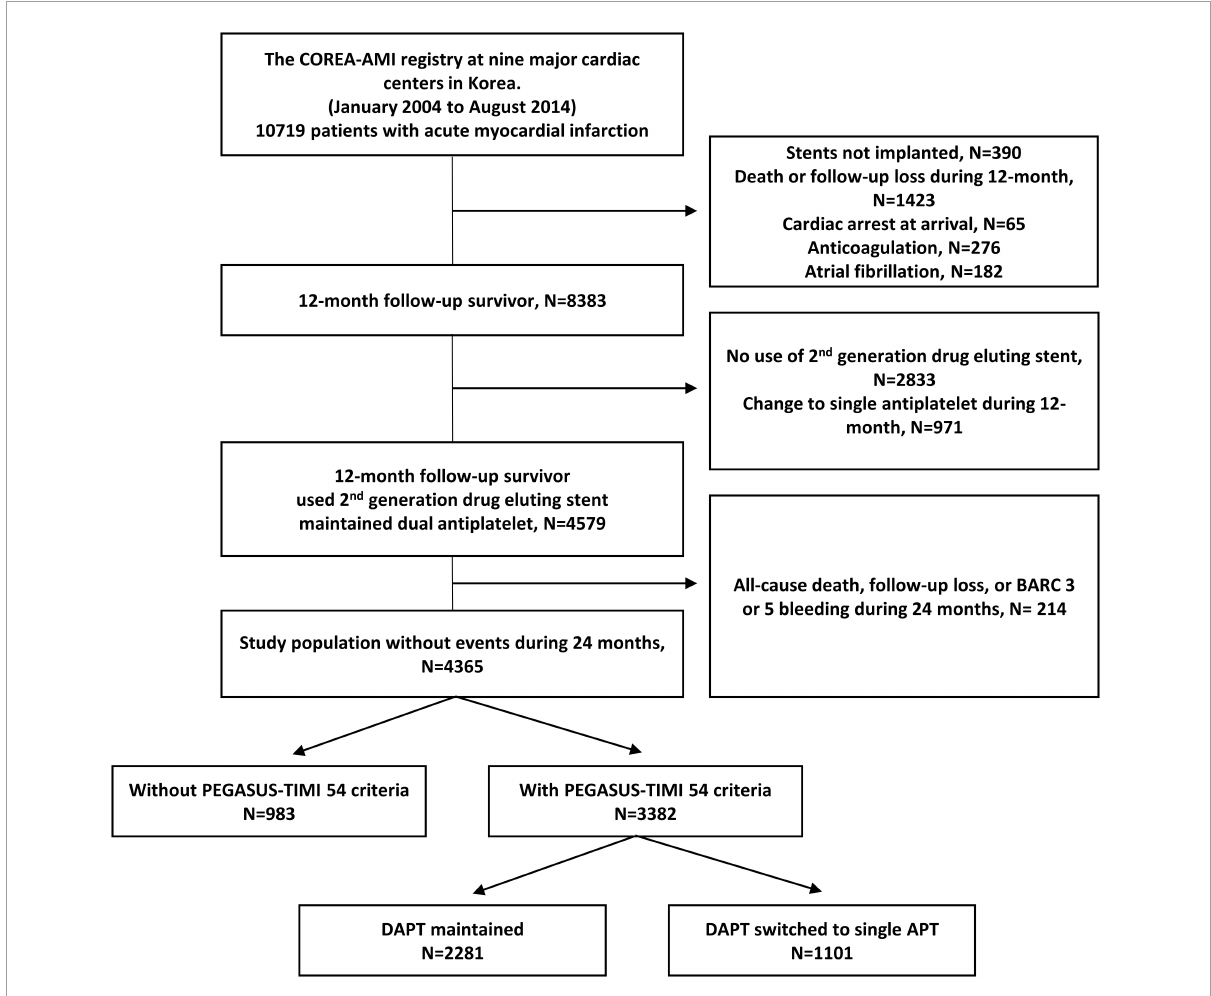
FIGURE1 Study flowchart. DAPT, dual antiplatelet therapy; BARC, bleeding academic research